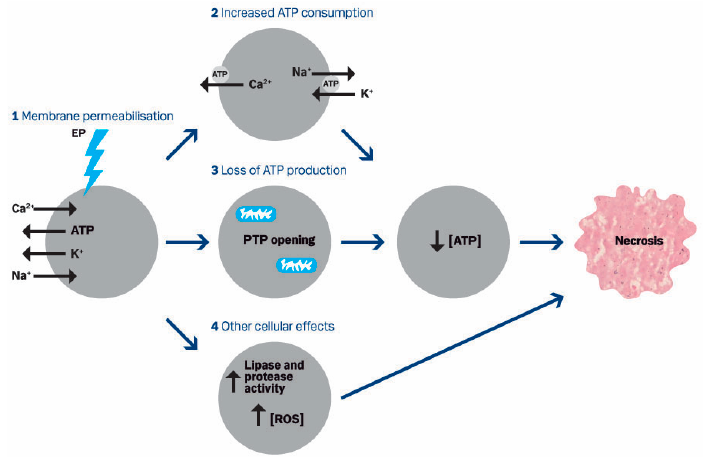
Figure 4. Proposed mechanism of action published in 2012. Calcium electroporation of cells induces influx of calcium and sodium and loss of ATP and potassium due to the concentration gradients ( 1 ).